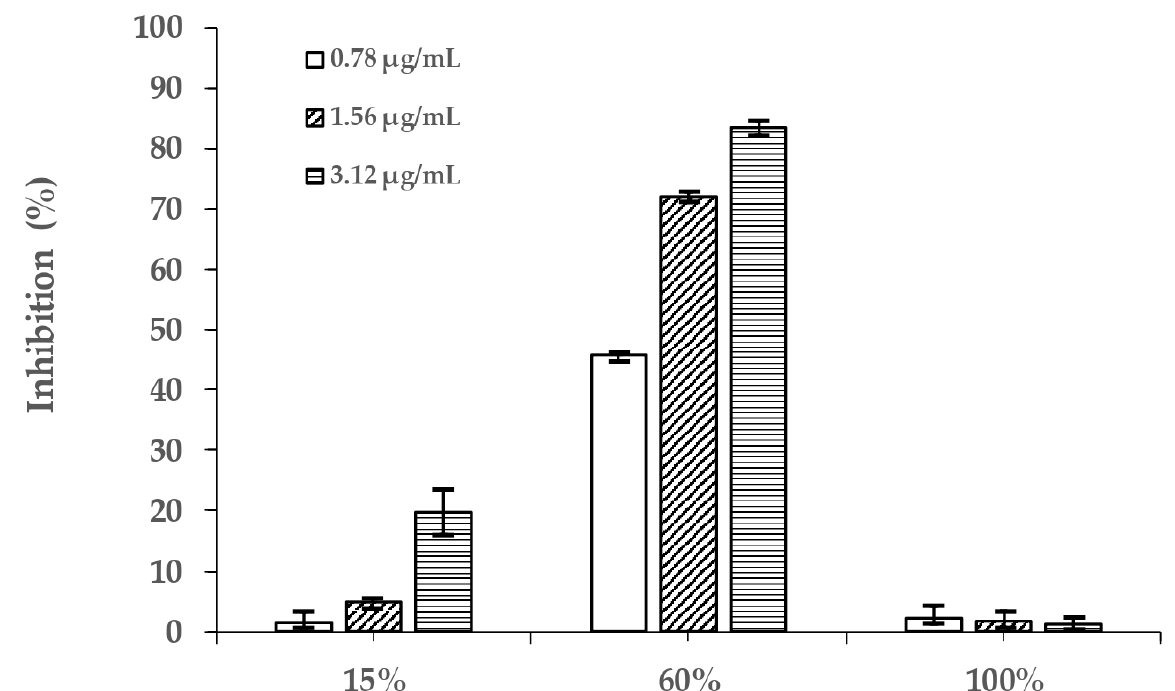
Figure 1. The inhibition (%) of three PVR fractions.